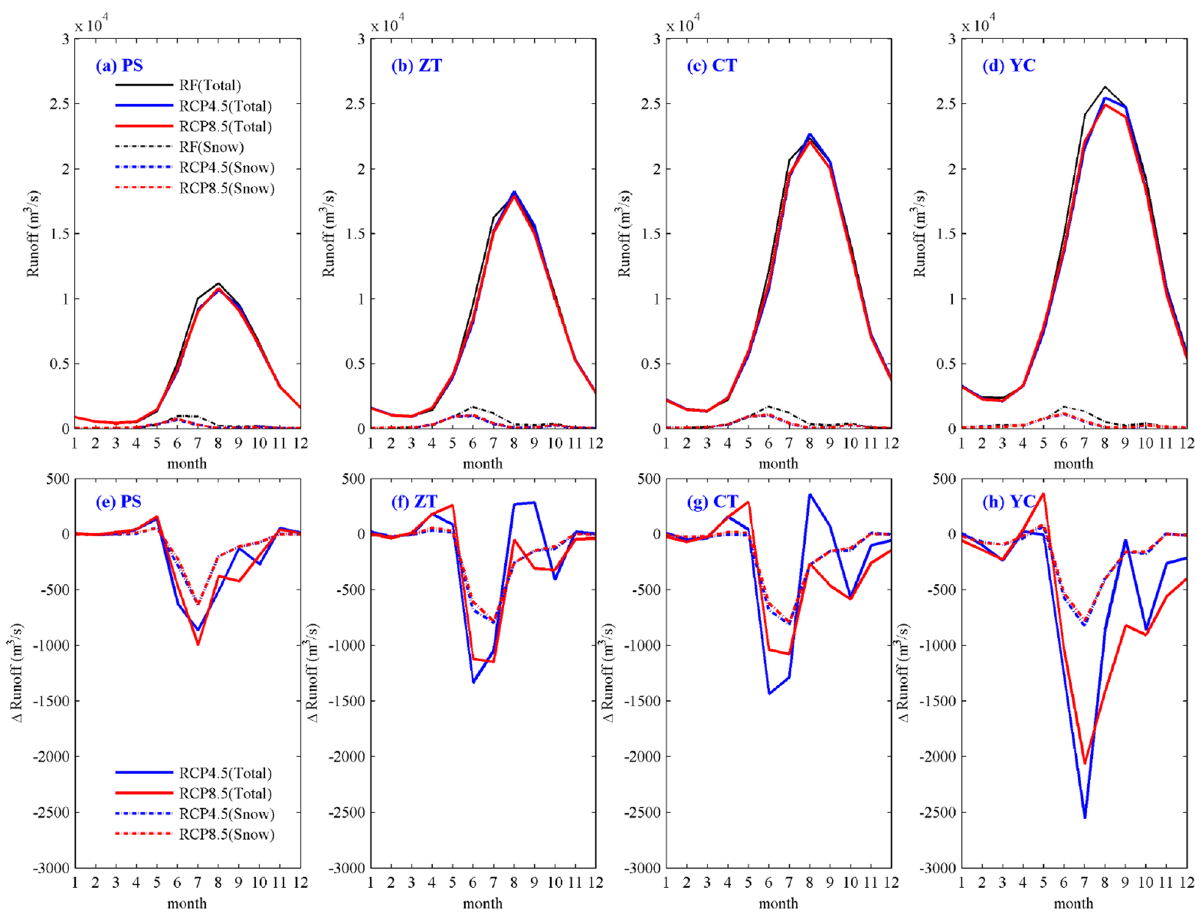
Figure 10. The multiyear average runoff process (a–d) of the R t (solid line) and R s (dashed line) for the PS, ZT, CT and YC stations under the RCP4.5 and RCP8.5 scenarios and the corresponding changes (e–h) . (The black color represents the reference period; the blue and red colors represent RCP4.5 and RCP8.5, respectively). The figure was generated by MATLAB2019a (https:// www. mathw orks.